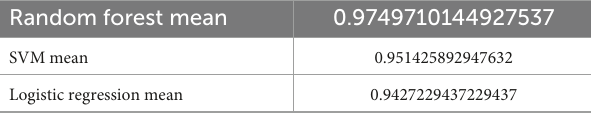
TABLE 1 Mean f1 scores in training in-house data.